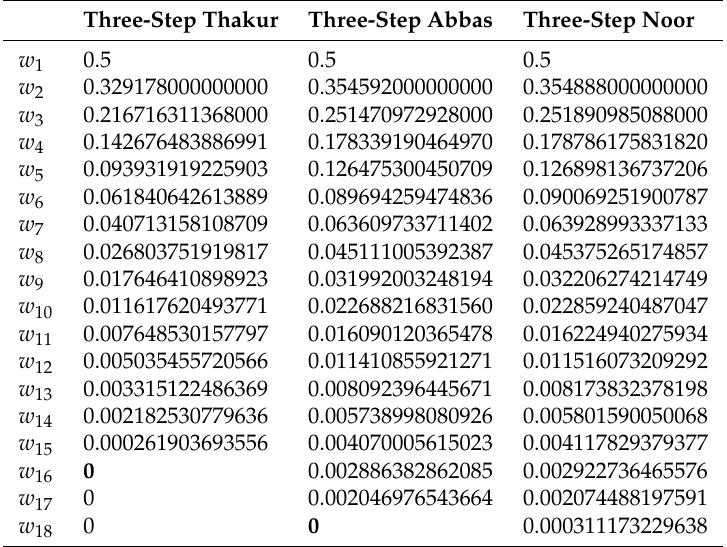
Table 1. Strong convergence of three-step iterative processes while using T given in Example 1. Three-Step Thakur Three-Step